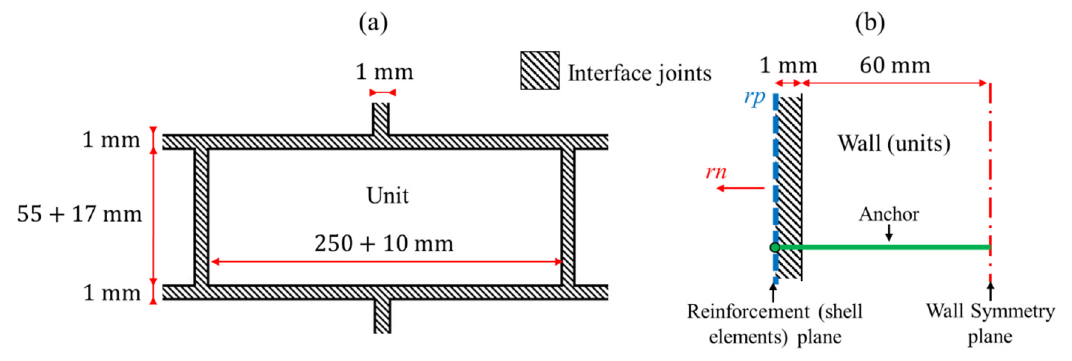
Figure 9. Modelling of ( a ) masonry wall and ( b ) wall–reinforcement interaction.